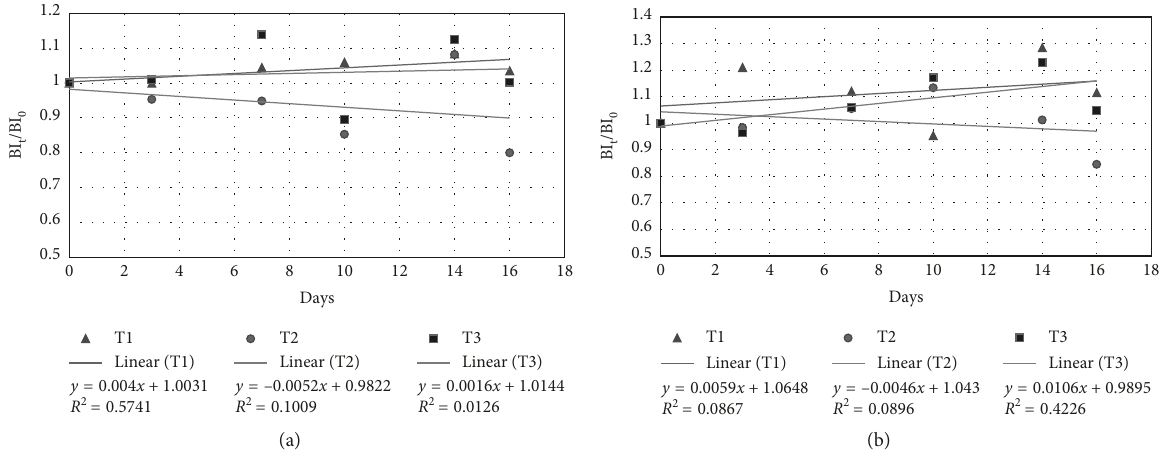
Figure 3: Leaves discoloration expressed as the browning index (BI) in dark (a) and light (b) conditions. Data are the ratio between the value at a given storage time ( t ) and the initial value